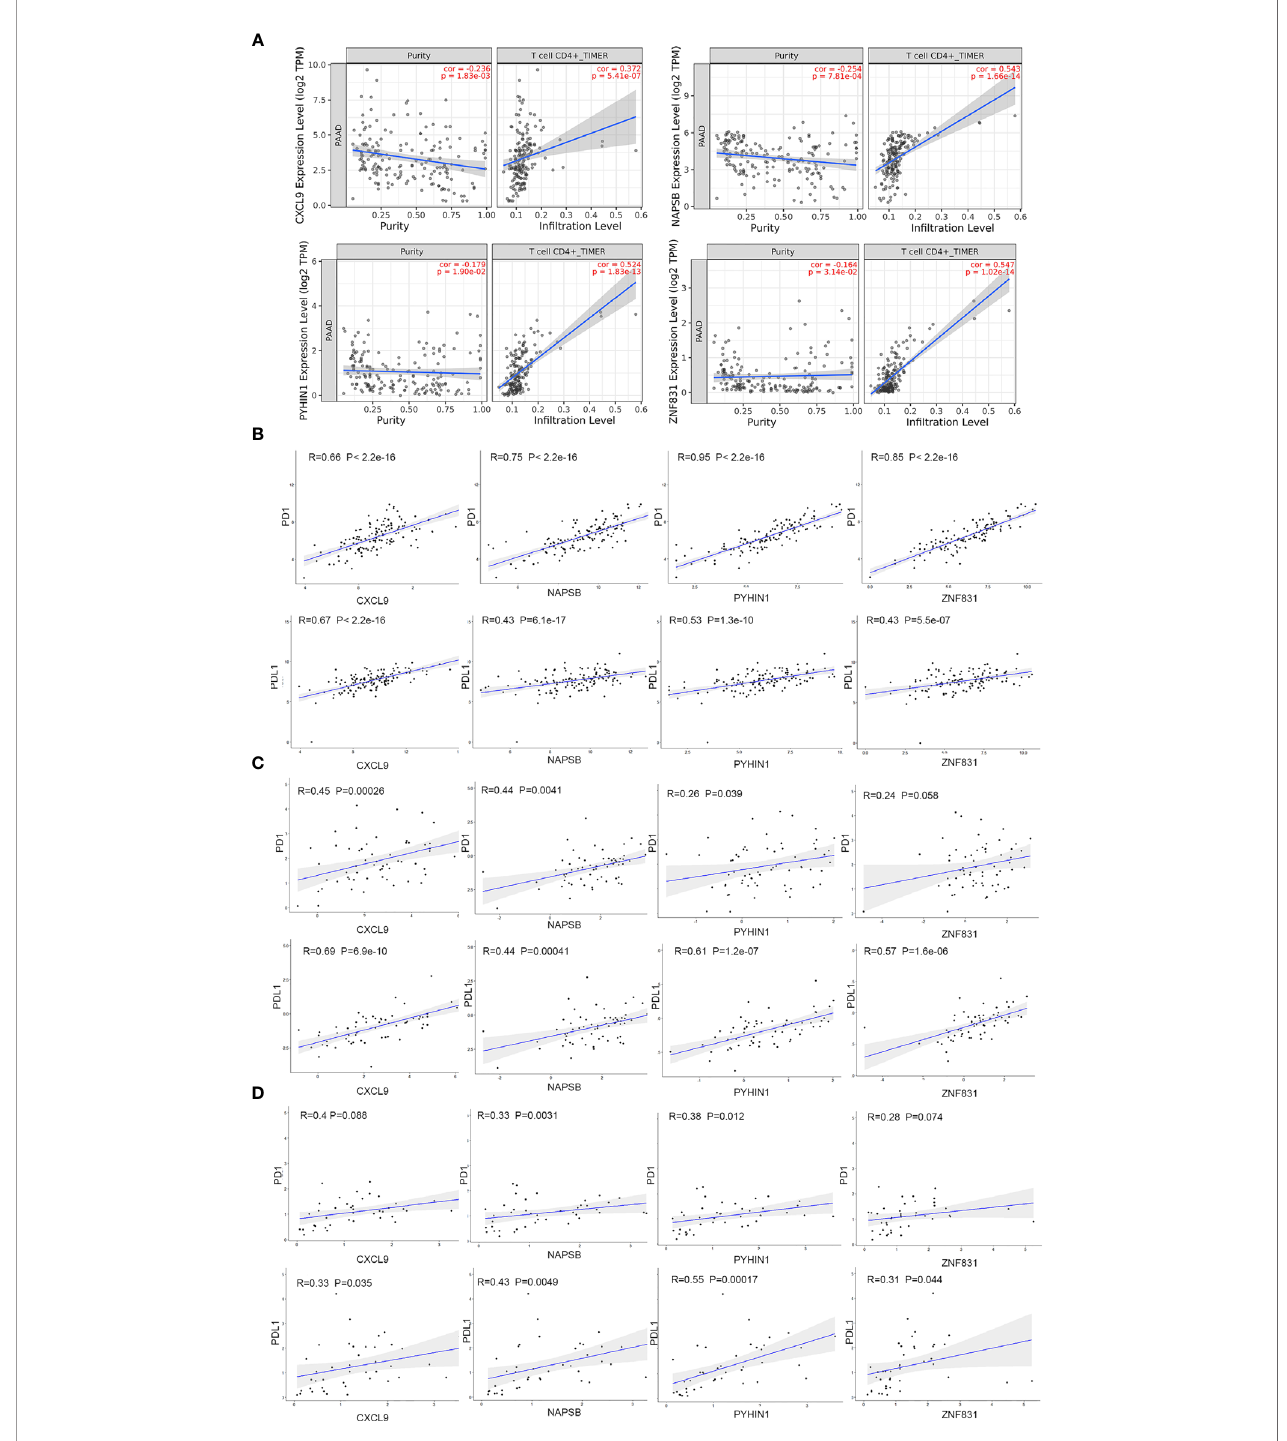
FIGURE 6 | NAPSB, ZNF831, CXCL9 and PYHIN1 associated with CD4+ T lymphocyte in fi ltration and immunosuppression markers. (A) The Timer web tool was performed to estimate the association between the expression levels of four genes with the in fi ltration level of CD4+ T immune cells in PDAC samples. (B) Correlation between four-gene expression and PD1 and PDL1 in PDAC samples of TCGA dataset. Top of Scatter plots depicts R2 and p-values. (C) Correlation between four- gene expression and PD1 and PDL1 in PDAC samples of ICGC dataset. (D) Correlation between four-gene expression and PD1 and PDL1in PDAC samples of FUSCC